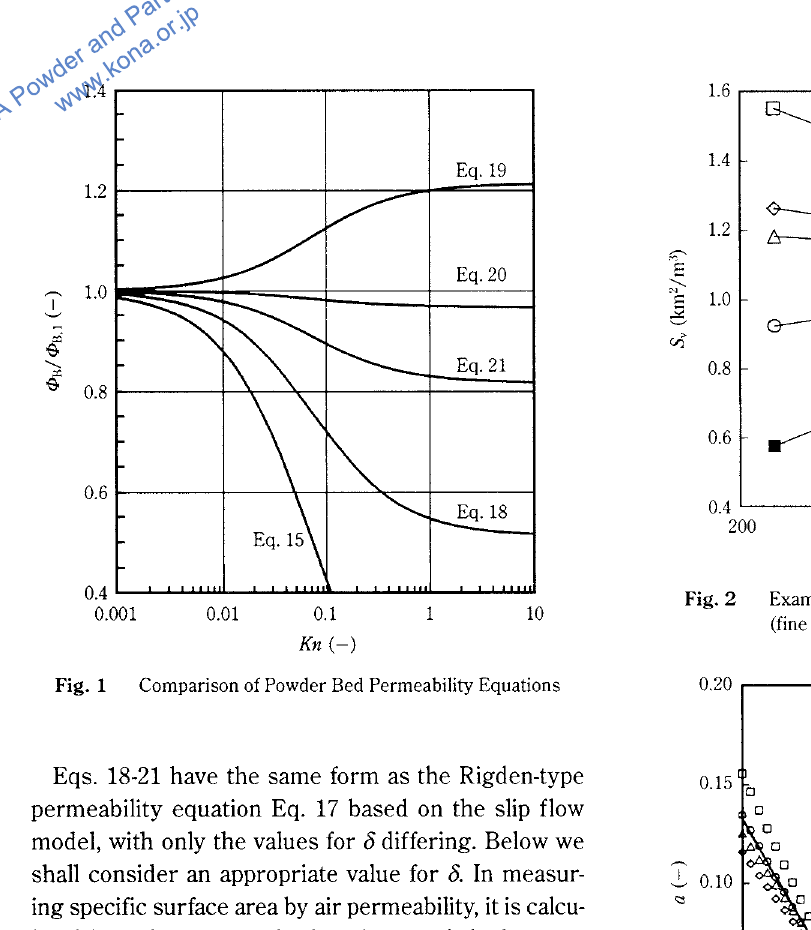
Fig. 1 Comparison of Powder Bed Permeability Equations